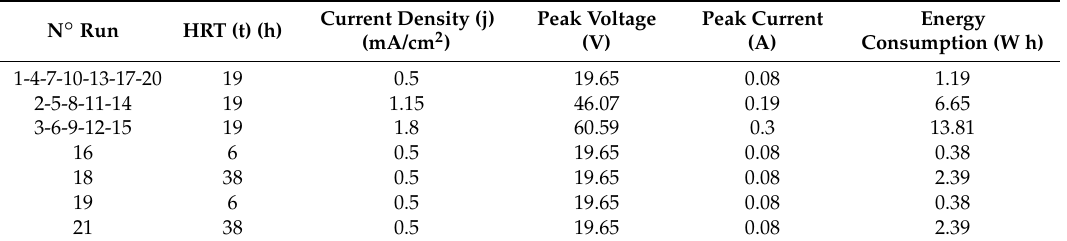
Table 3. Applied voltages, current intensities and energy consumptions of the different experimental runs. N ◦ Run HRT (t) (h)